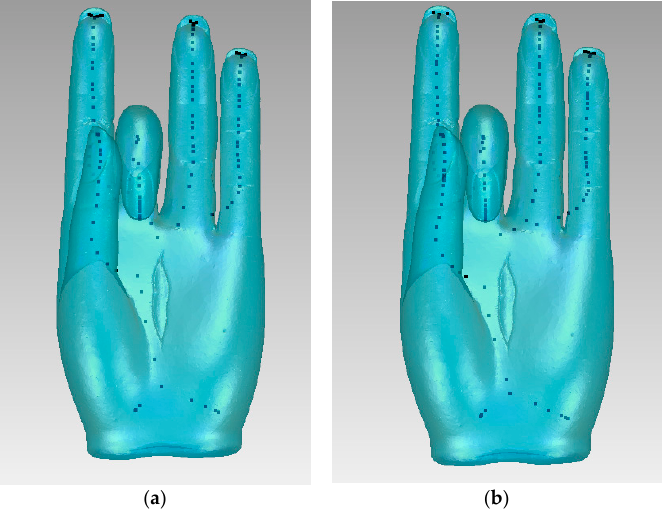
Figure 9. Simplification result of QEM (Quadric error metrics) skeleton nodes under different weights: ( a ) a = 1, and b = 0.1, 130 skeleton nodes; ( b ) a = 1 and b = 1, 149 skeleton